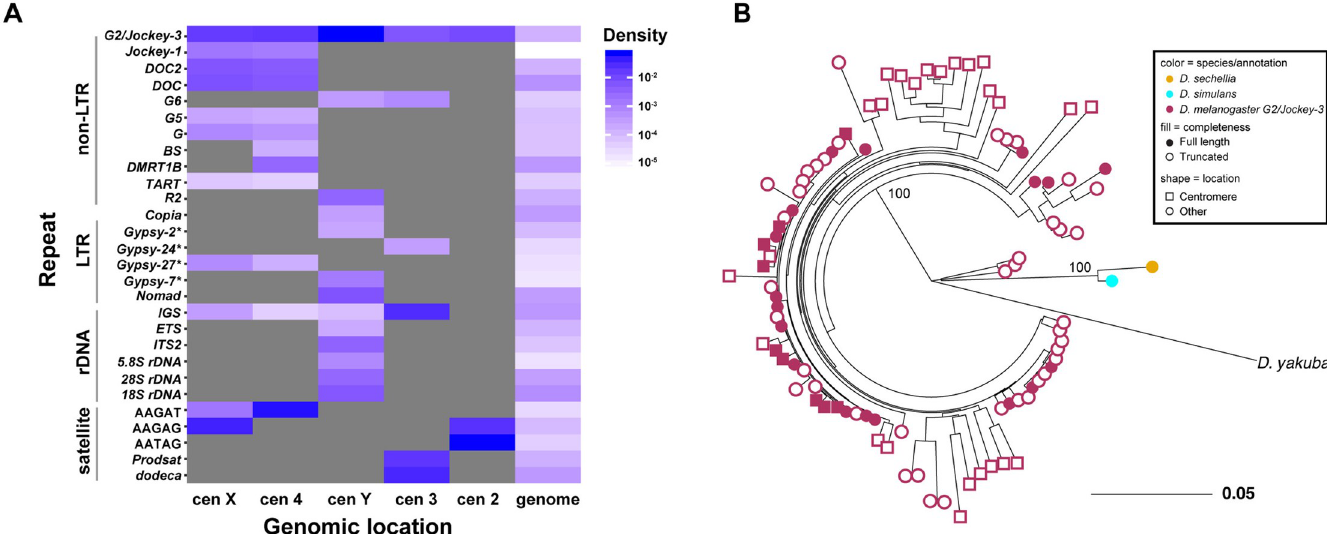
Fig 3. Centromeres are enriched in non-LTR retroelements in the Jockey family. (A) Density of all repetitive elements on each candidate centromere contig and the entire genome (minus the centromeres) grouped by type: non-LTR retroelements, LTR retroelements, rDNA-related sequences, and simple satellites. G2/Jockey-3 is present on all centromeres. An � indicates annotations based on similarity to retroelements in other Drosophila species: Gypsy-2 is from D . simulans , Gypsy-24 and Gypsy-27 are from D . yakuba , and Gypsy-7 is from D . sechellia . For annotation, see Dryad repository file 9: https://doi.org/10.5061/dryad.rb1bt3j [37]. The underlying data can be found in S1 Data. (B) Maximum-likelihood phylogenetic tree based on the entire sequence of all G2/Jockey-3 copies in D . melanogaster inside (squares) and outside (circles) of centromeric contigs and on the consensus repeat in its sister species D . sechellia and D . simulans and a more distantly related species ( D . yakuba ). The tree shows that centromeric G2/Jockey-3 elements do not have a single origin (see Dryad repository files 13 and 15: https://doi.org/10.5061/dryad.rb1bt3j [37]). Cen2, centromere 2; Cen3, centromere 3; Cen4, centromere 4; CenX, X centromere; CenY, Y centromere; ETS , external transcribed spacer; IGS, intergenic spacer of the ribosomal genes; ITS , internal transcribed spacer; LTR, long terminal repeat; Prodsat , Prod satellite; TART , Telomere-associated retrotransposon.